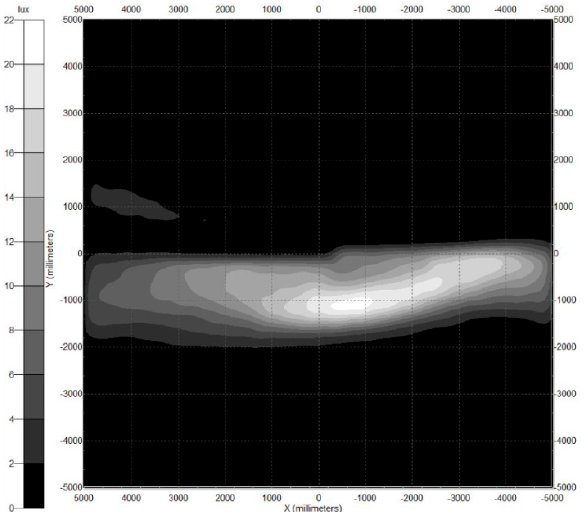
Figure 11. Simulated illuminance distribution of the low-beam light generated by the proposed headlamp.